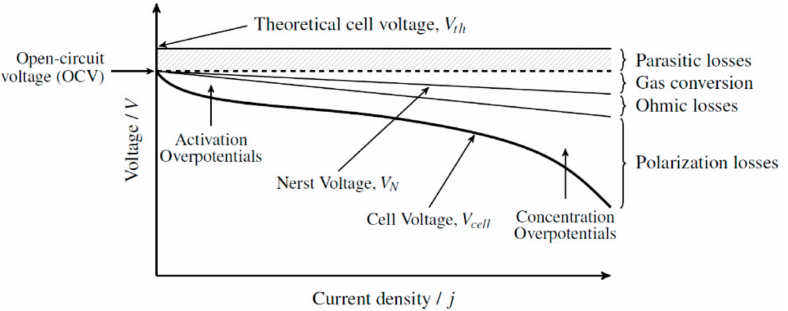
Figure 2. Typical SOFC polarization curve and identification of main voltage drop mechanisms